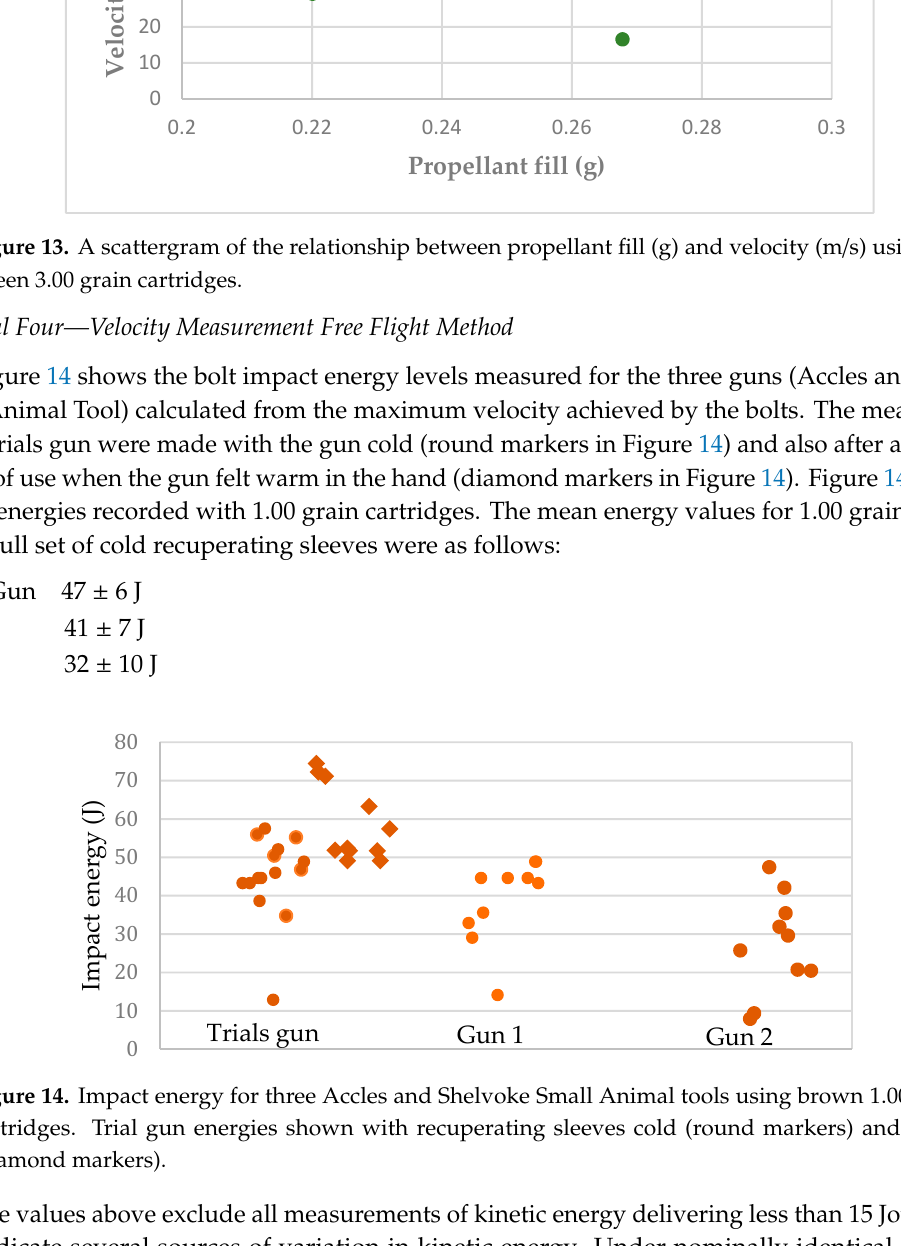
Figure 13. A scattergram of the relationship between propellant fill (g) and velocity (m/s) using 100 Green 3.00 grain cartridges.